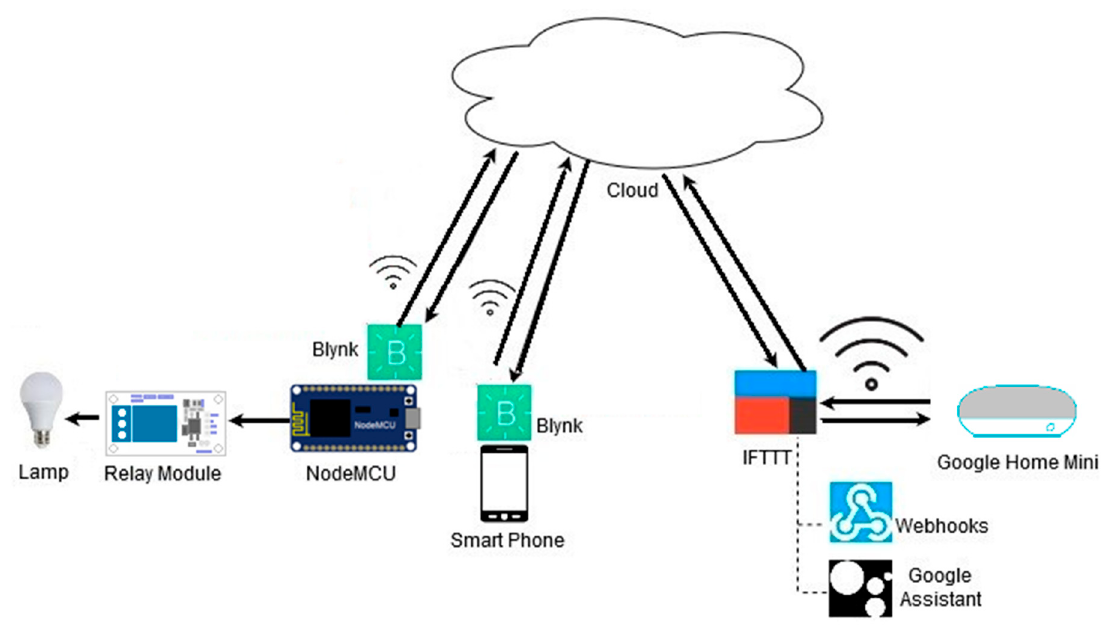
Figure 7. IoT device